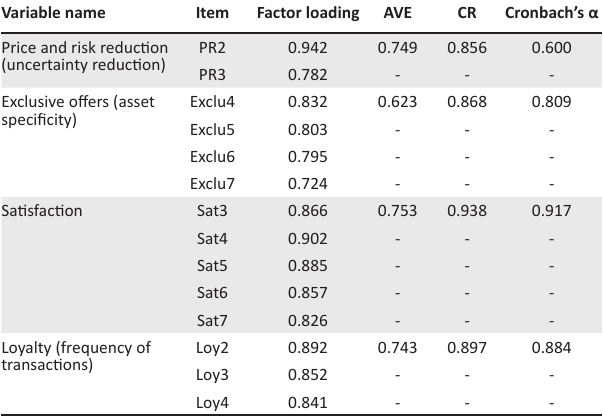
TABLE 3: Factor loadings, composite reliability, average variance extracted and Cronbach’s alpha values. Variable